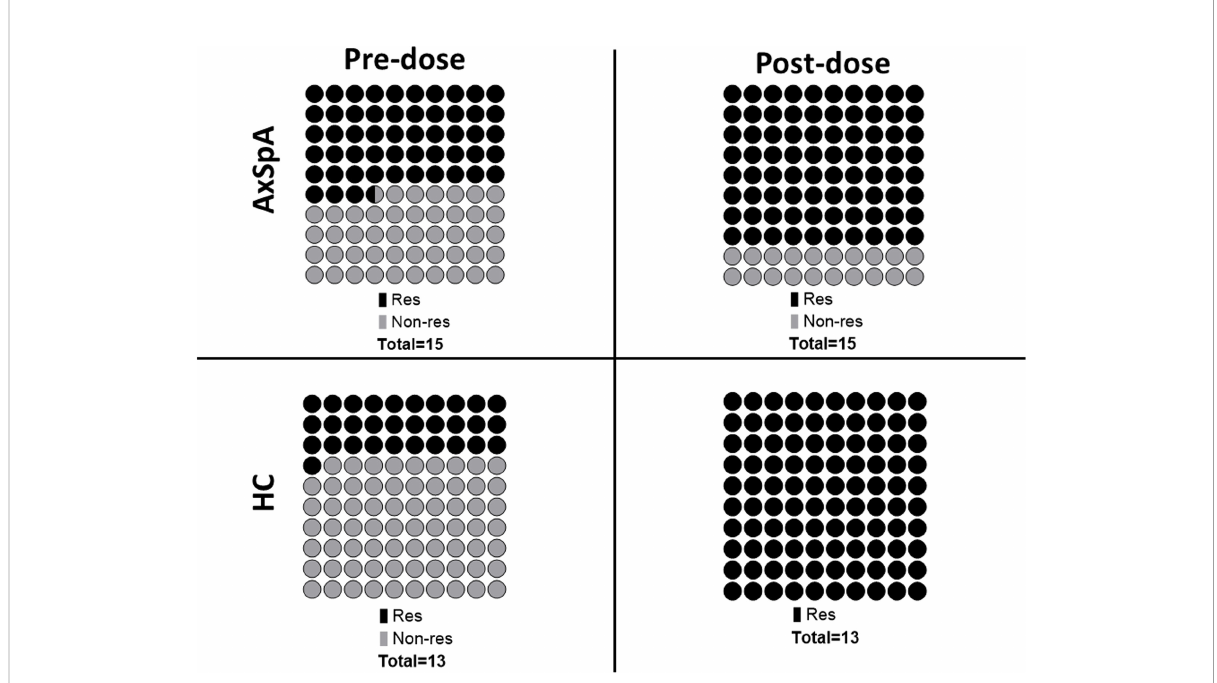
FIGURE 4 Pre- (6 months after primary vaccination scheme) and post-dose (1 month after booster vaccination) proportions of T cell immune responses (de fi ned as 1.5-time increase in the proportion of CD4+IFN g + and/or CD4+TNF a + cells after speci fi c stimulation with SARS-CoV-2 derived peptides) between Axial spondyloarthritis (AxSpA) and Healthy control subjects (HC); responders marked as dark beads, non-responders marked as light beads, one bead represents 1% (of total); the differences between cohorts were not statistically signi fi cant.